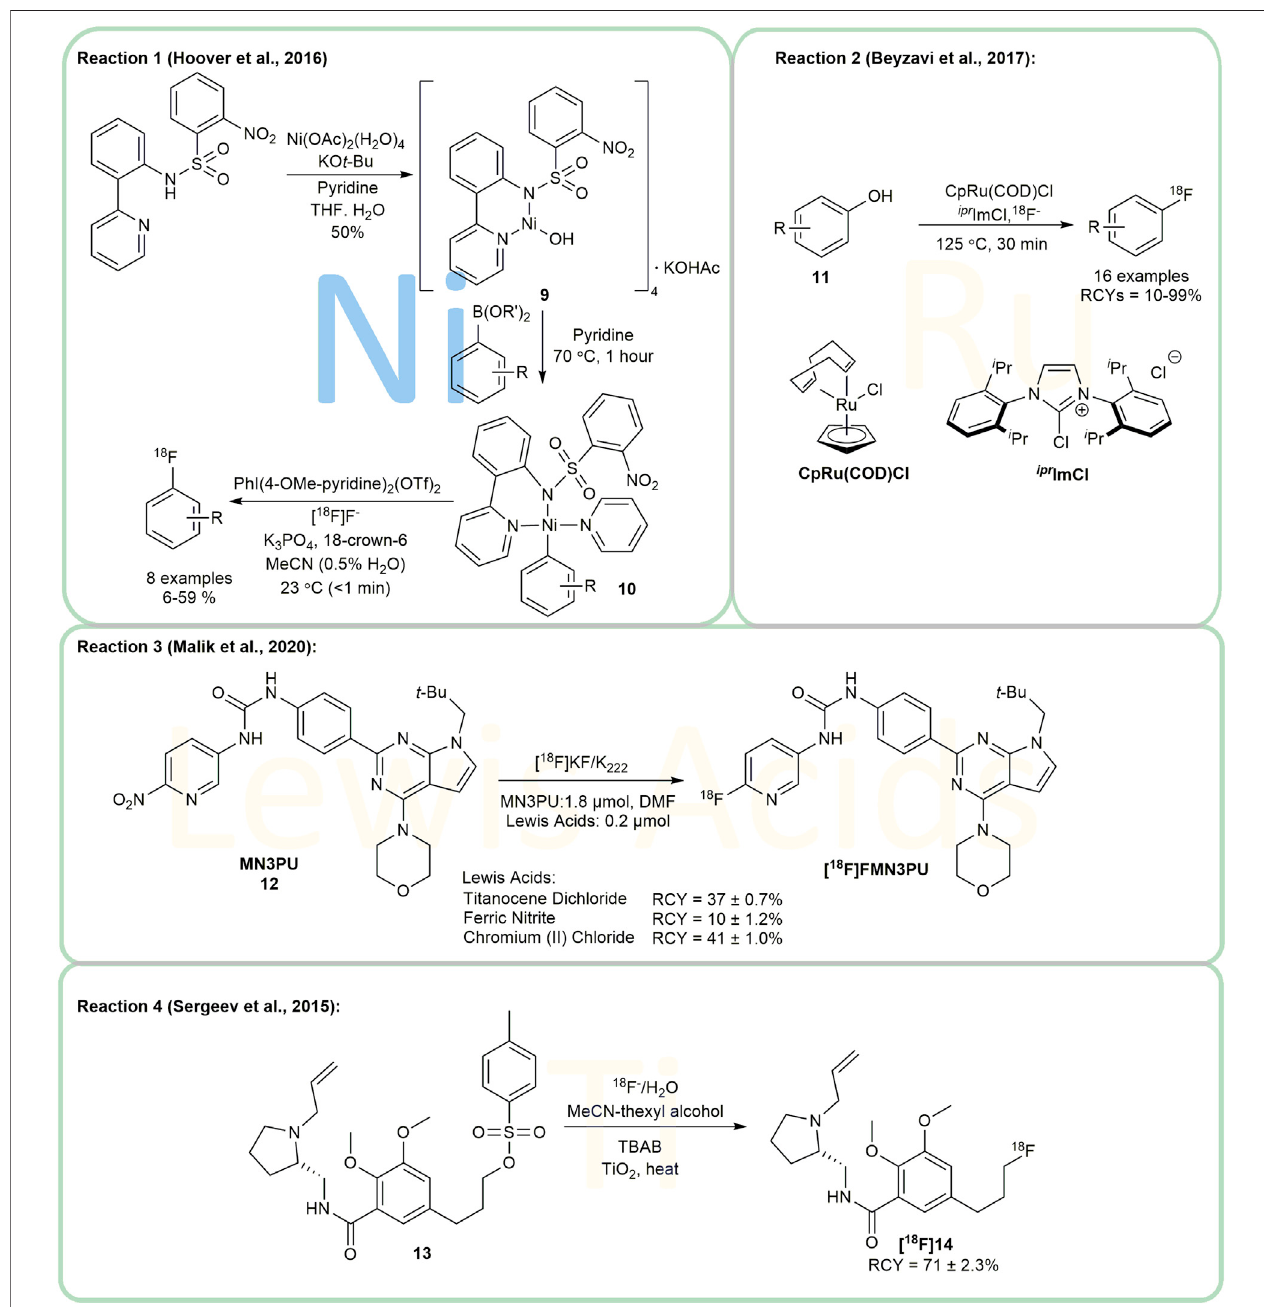
FIGURE 3 | Ni, Ru and other transition metal mediated/catalyzed radio fl uorination.